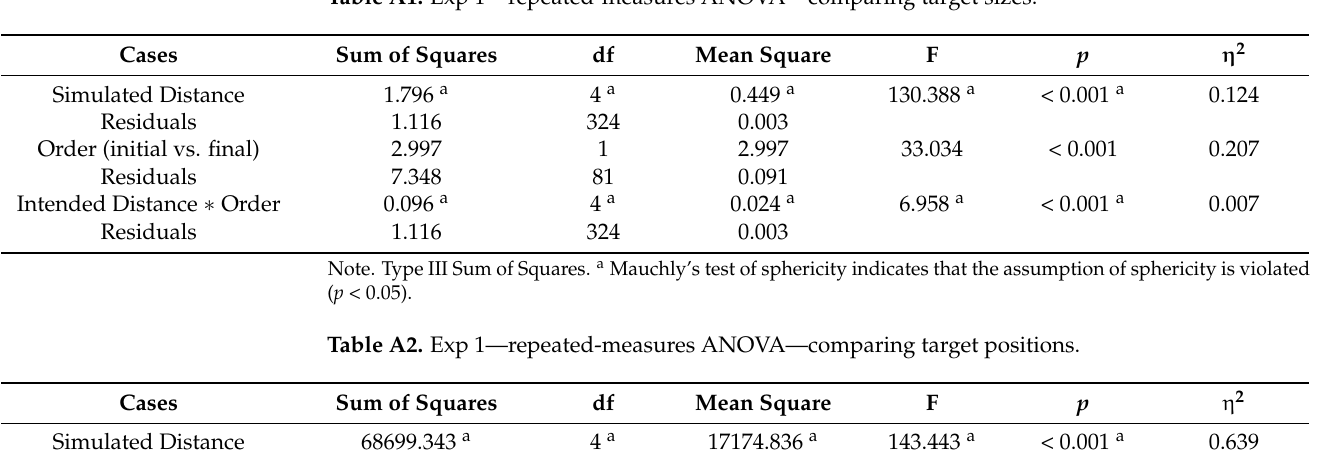
Table A1. Exp 1—repeated-measures ANOVA—comparing target sizes.